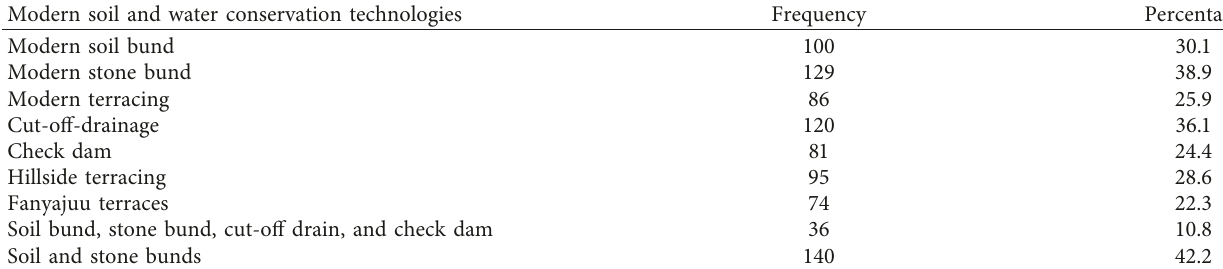
Table 5: The most recent soil and water conservation technologies in the study